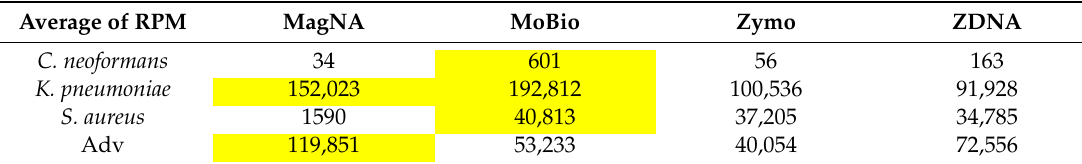
Table 4. Average reads per million (RPM) from DNA sequencing for the pathogens included in the mock sample using di ff erent protocols. Average of RPM MagNA